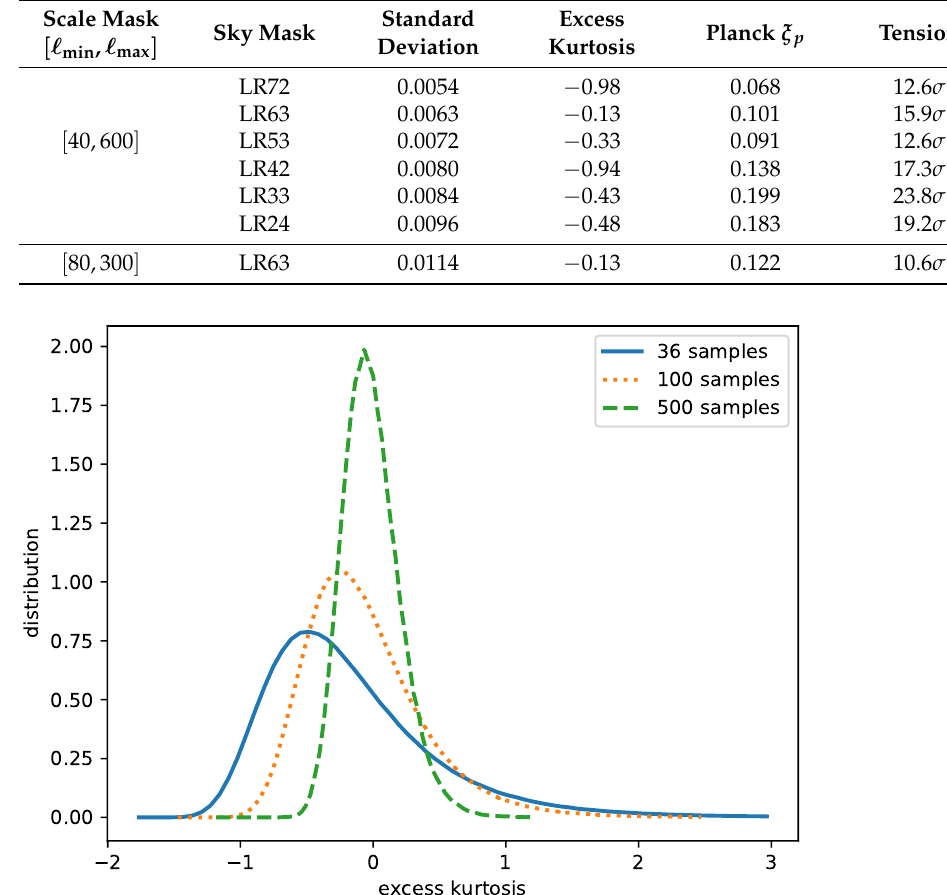
Figure 3. Distribution of excess kurtosis of a given number of random Gaussian